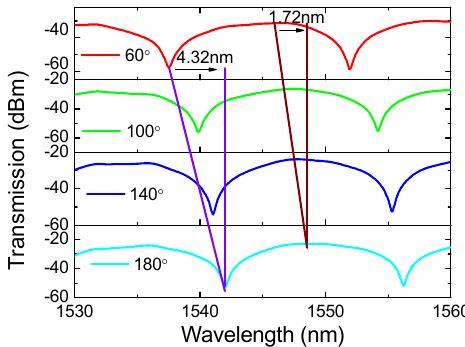
Figure 6. Interference fringe peak and dip wavelength shift with the changed θ τ .